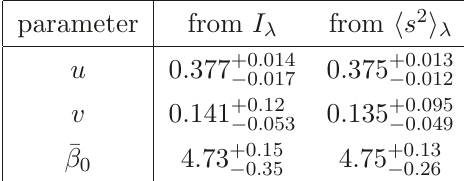
Figure 12 . Dependence of ¯ β 0 and v on m max in a constrained fit of λ c (¯ β ), obtained from I λ (left) and s 2 (right), with the function eq. (4.8). h i λ